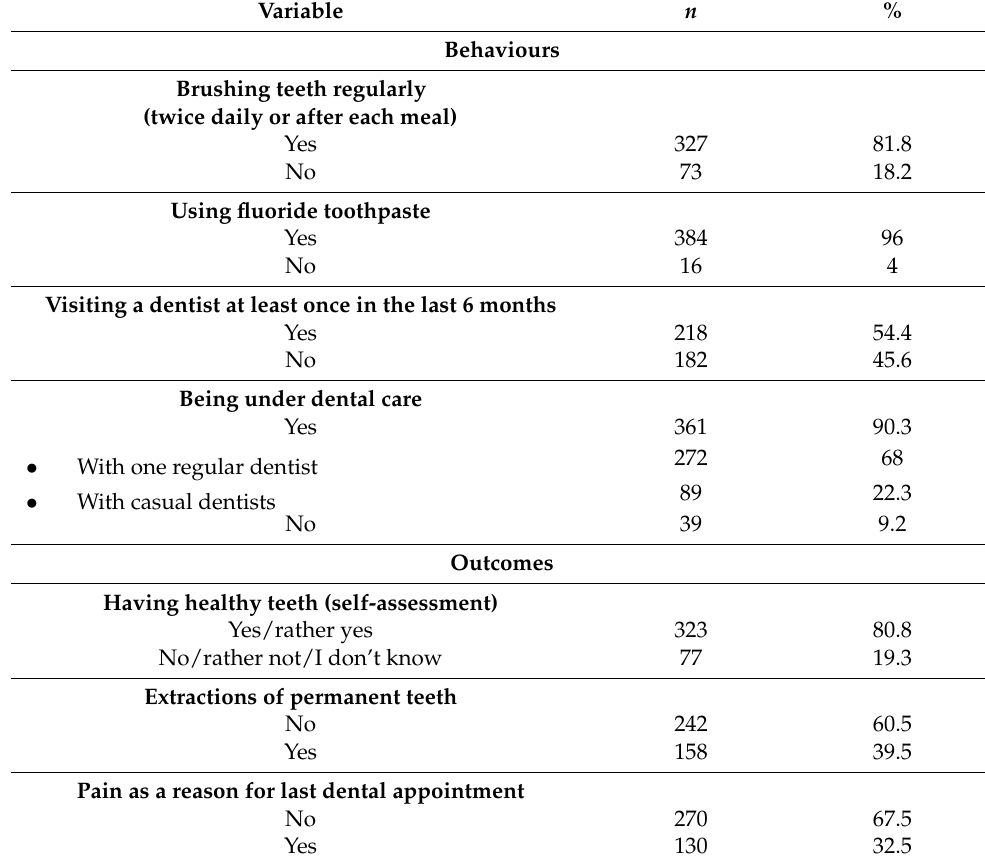
Table 2. Reported maternal oral health behaviours and outcomes ( n = 400). Variable n %